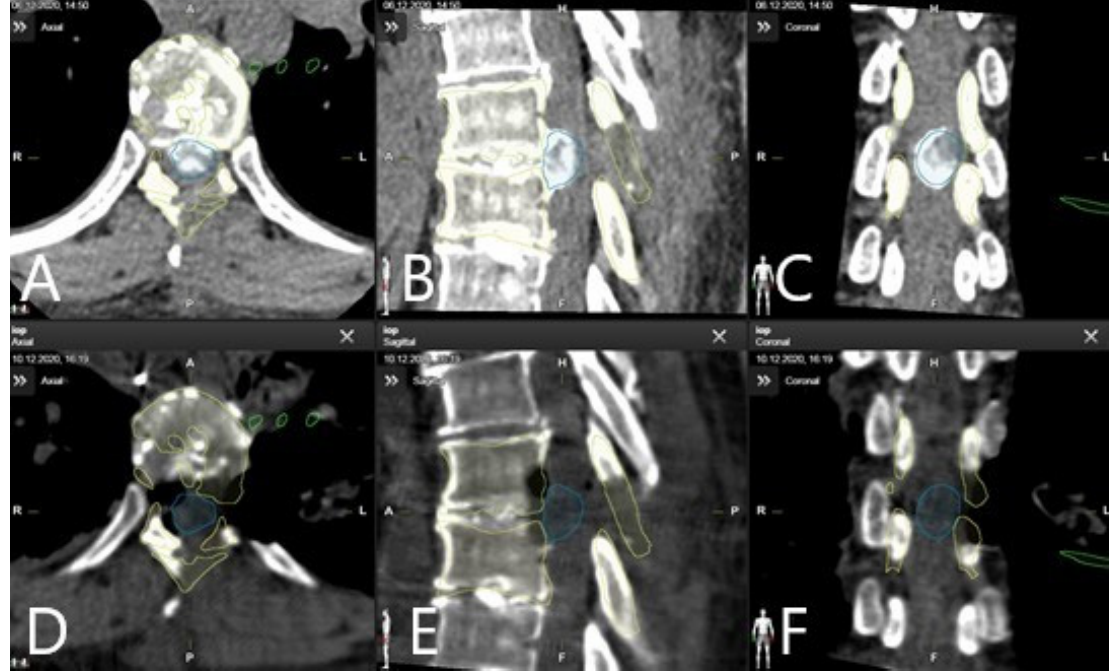
Figure 8. A 46-year-old patient with large calcified herniated disc Th 7/8, who underwent previous surgery in an external hospital with left-sided hemilaminectomy Th7/8 (patient no. 15). Due to worsening of the paraparesis following the primary surgery, patient was transferred to our department. Left lateral transpleural approach with costotransversectomy and complete resection of the herniated disc was performed. Intraoperative CT scan used for navigation registration performed following implantation of the retractor in ( A ) axial, ( B ) sagittal, and ( C ) coronal view, with segmented herniated disc (blue), vertebra Th7 and Th8 (yellow), and the XLIF–retractor (green). Control CT scan for extent of resection in ( D ) axial, ( E ) sagittal, and ( F ) coronal view shows complete resection of the herniated disc following costotransversectomy via a left lateral transpleural approach.